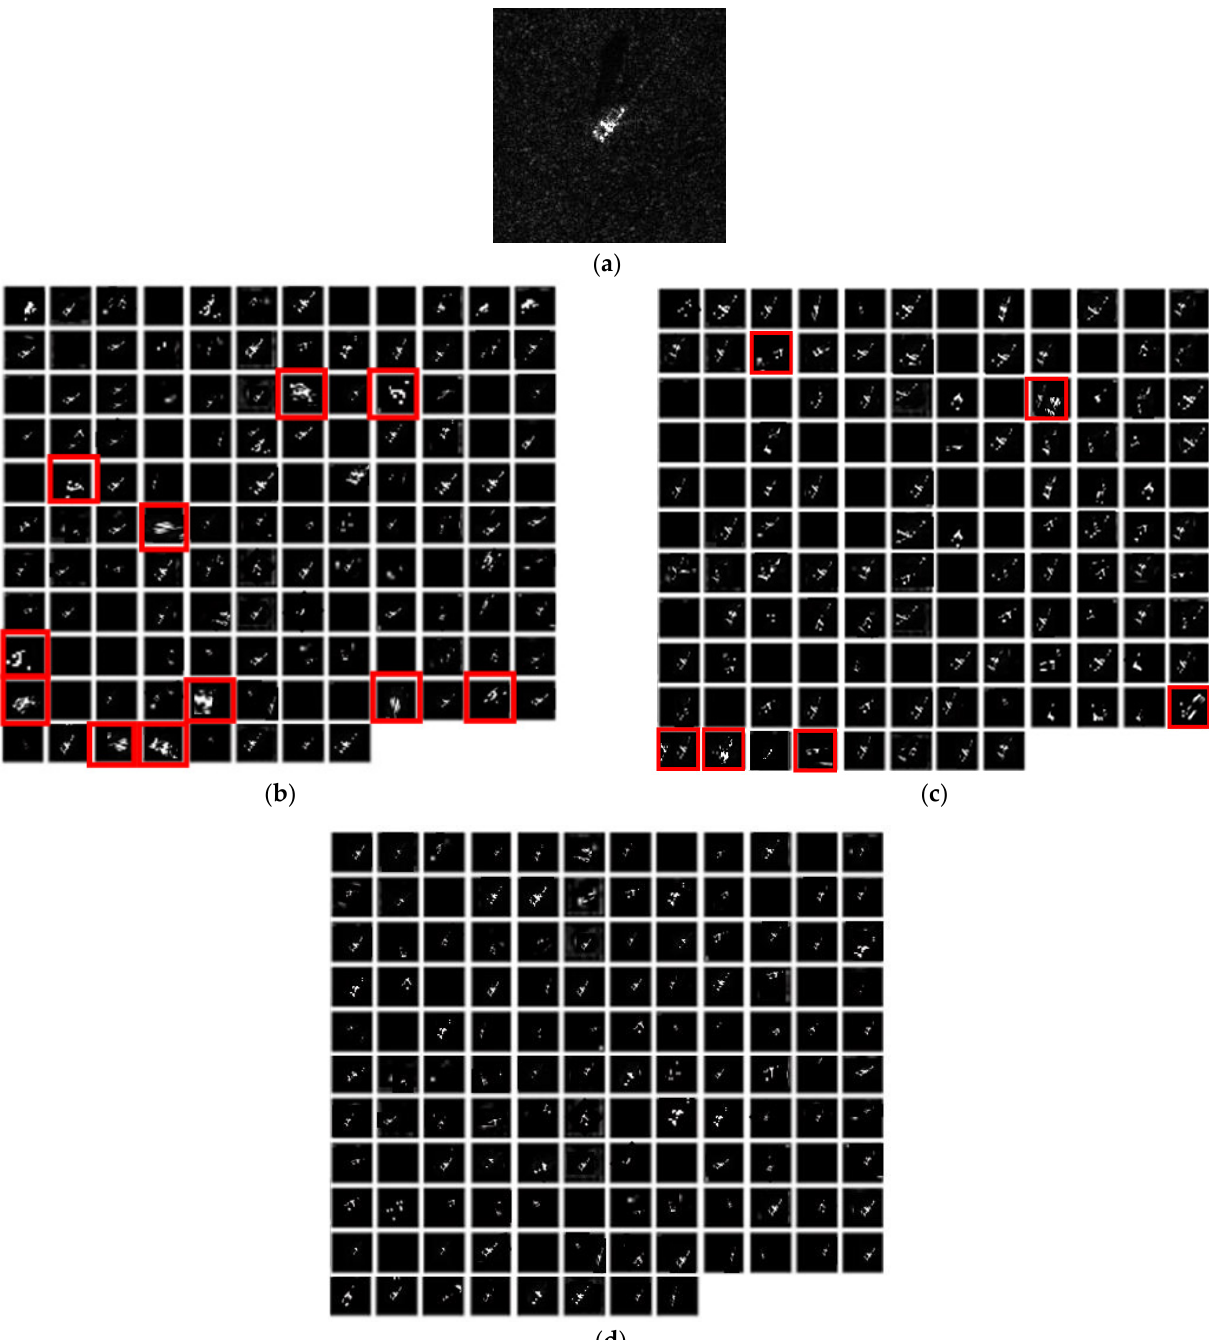
Figure 13. Feature map output: ( a ) original image; ( b ) ADMF-CNN; ( c ) ADMF-FCNN; ( d ) ADMF-IFCNN.